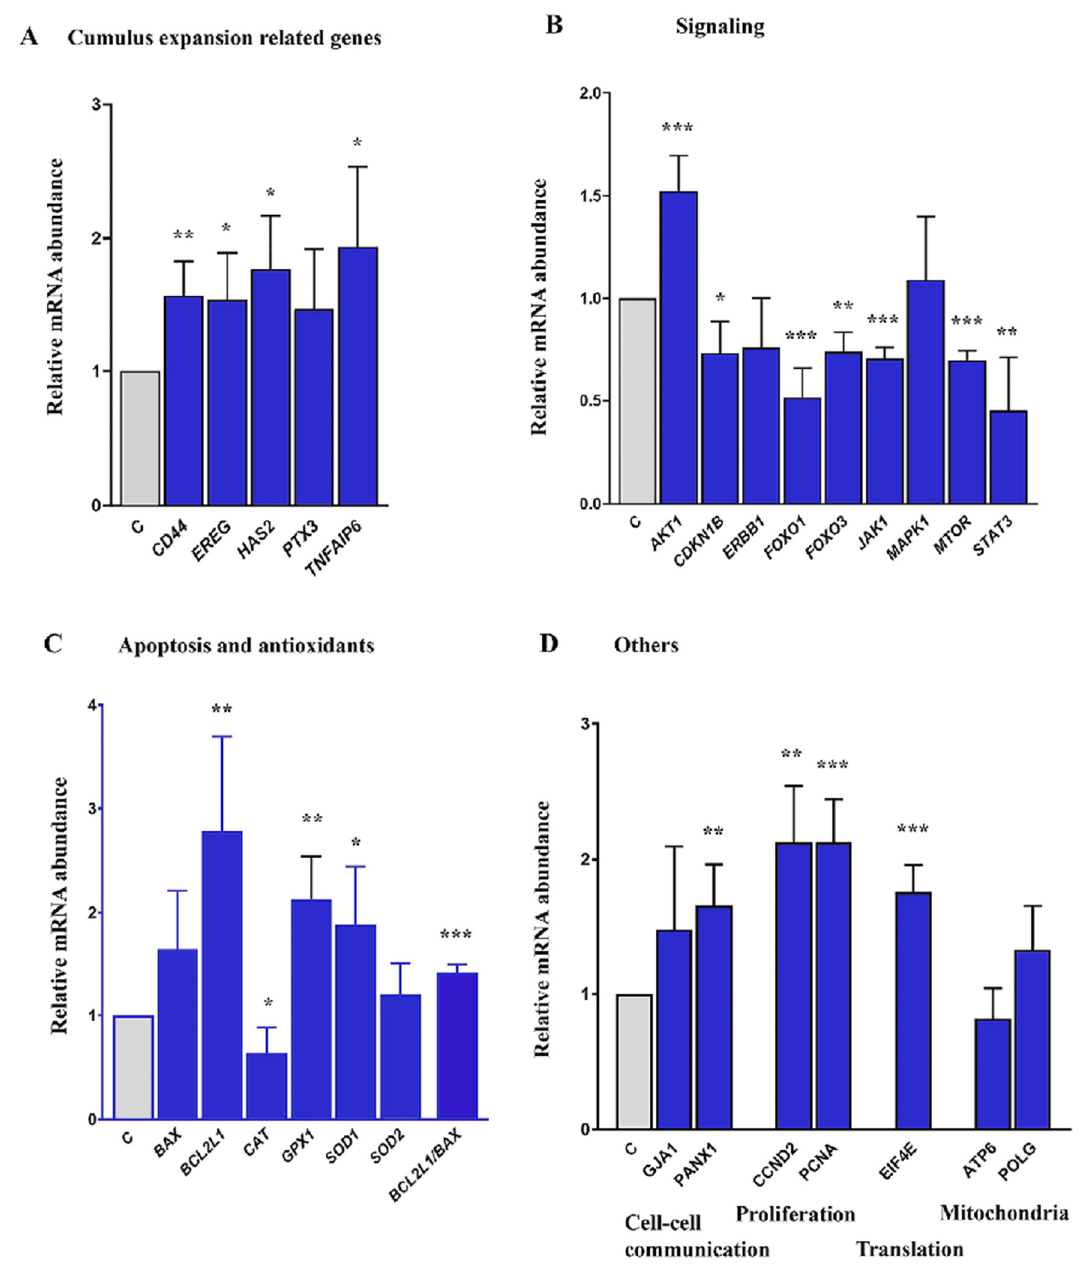
Figure 3. Gene expression in cumulus cells (CCs) cultured in control and FLI medium. Cumulus expansion-related genes ( A ), signaling pathways-related genes ( B ), genes related to apoptosis and antioxidants ( C ), and others ( D ). Differences are expressed in arbitrary units as the fold increase over the proportion found in CCs cultured in control ( C ). Asterisks above the columns indicate significant differences between the treatments at the same time of culture ( p < 0.05 for single asterisk; p < 0.01 for double asterisk, p < 0.001 for triple asterisk).